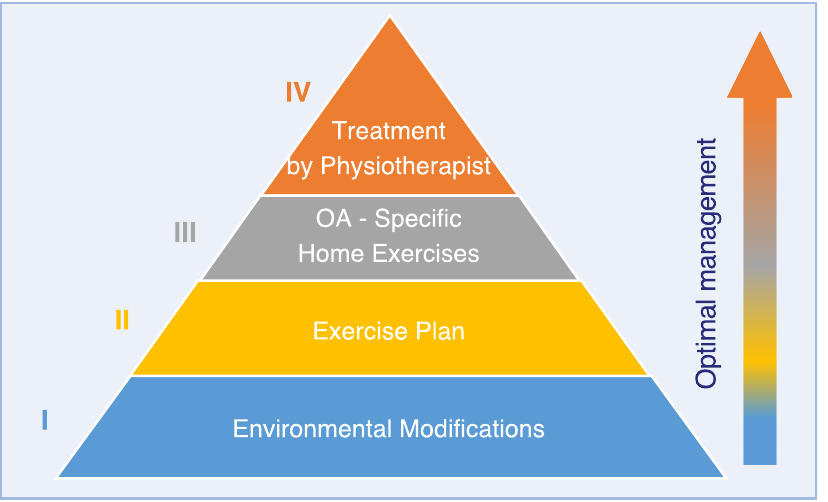
Figure 1. Physiotherapy Pyramid for a systematic approach to canine OA management.